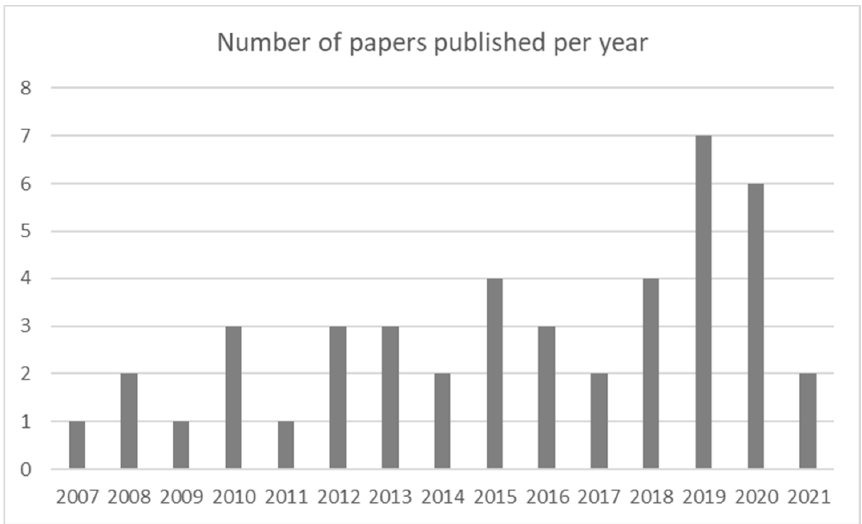
Figure 4. Number of papers published per year.